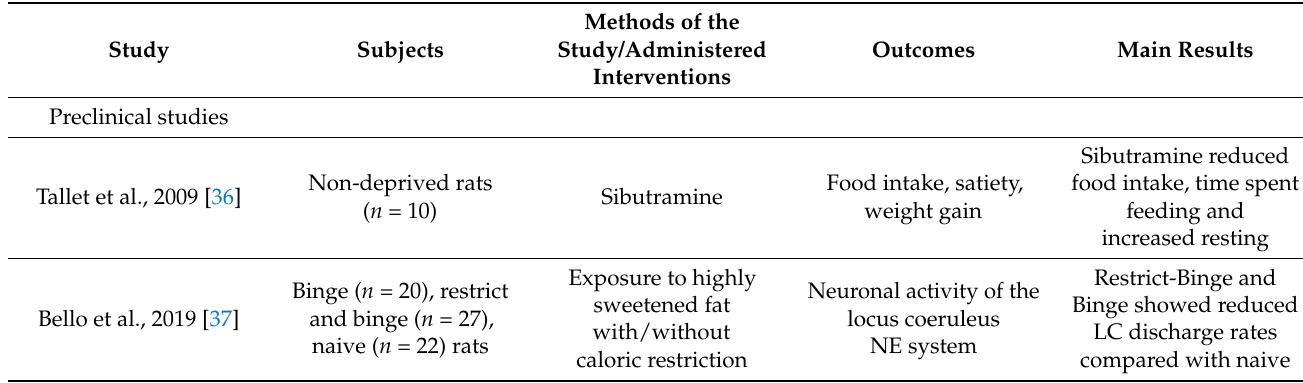
Table 1. Characteristics and main results of the included